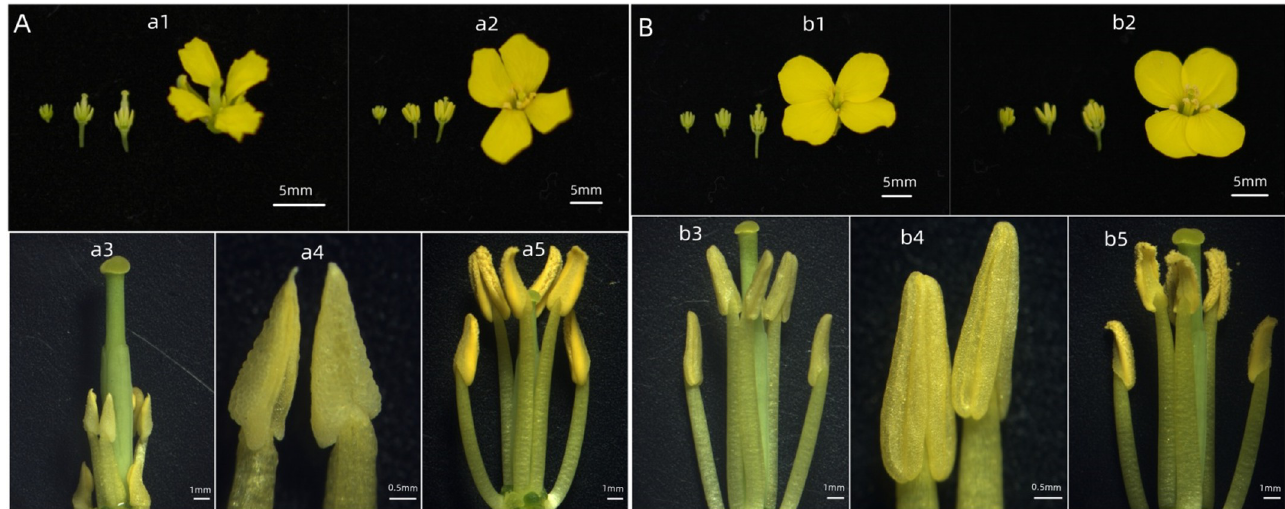
Fig 1. Morphological observation of flower organs. (A)The phenotype comparision between Pol CMS and maintainer. a1, a3, a4: Flowers of P5A. a2, a5: Flowers of P5B; (B) The phenotype comparision between Nsa CMS and maintainer. b1, b3, b4: Flowers of 1258A; b2, b5: Flowers of 1258B.